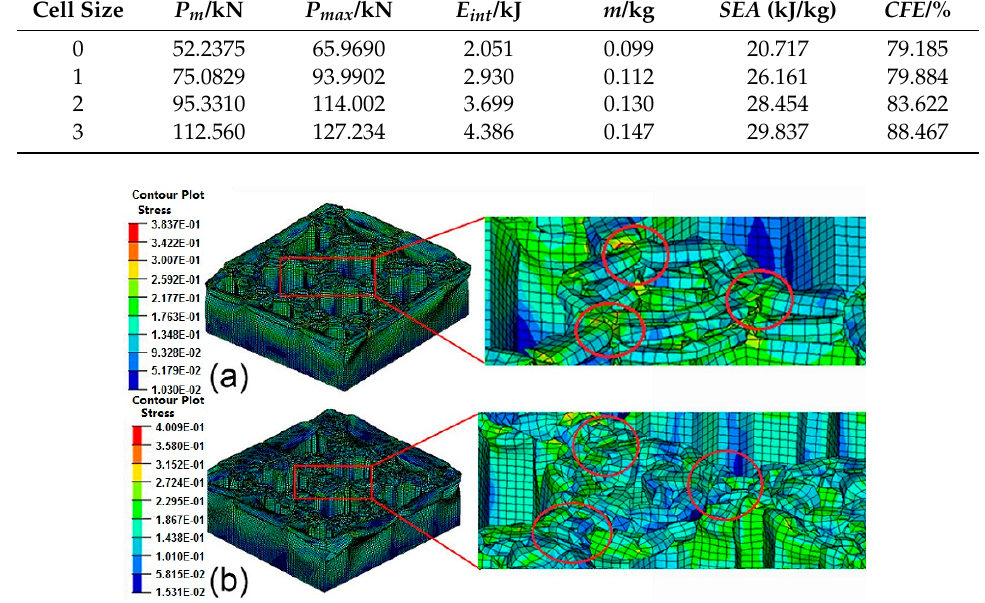
Figure 14. The deformation and stress contour of BHS under axial crushing: ( a ) BHS-1; ( b ) BHS-2.